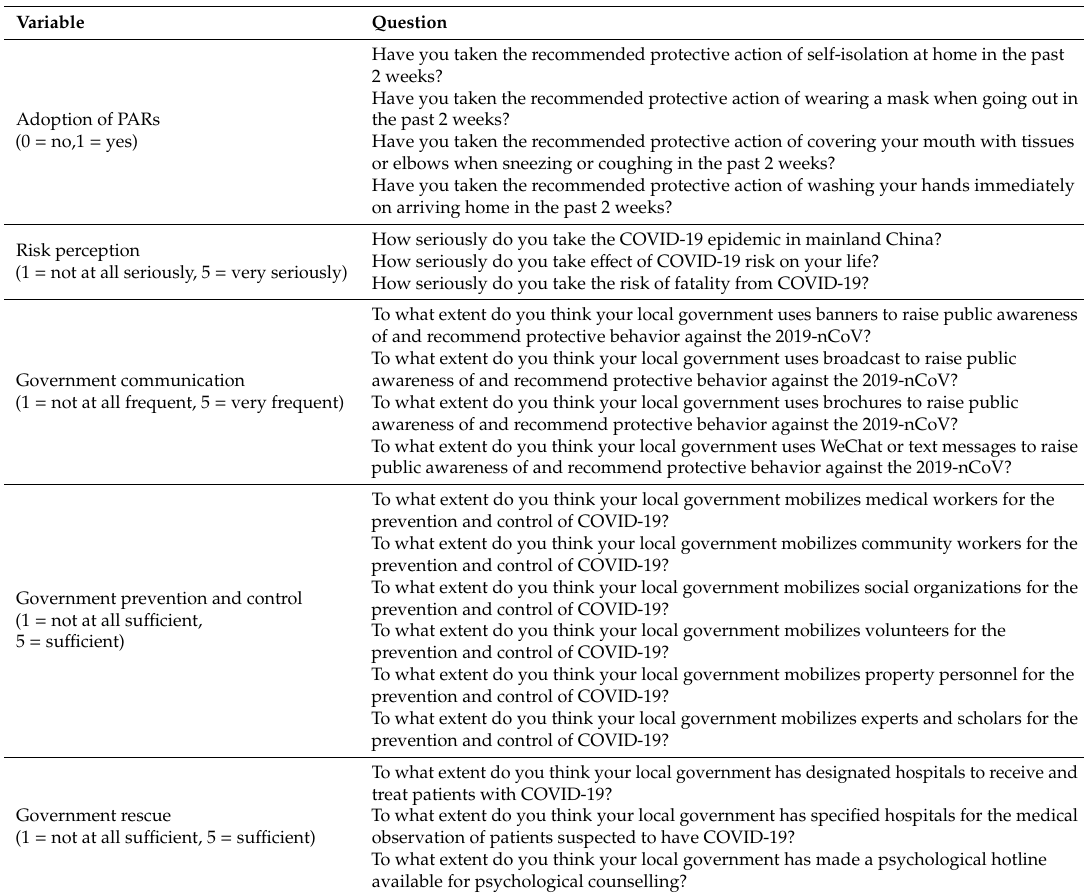
Table 1. Key variables and questionnaire